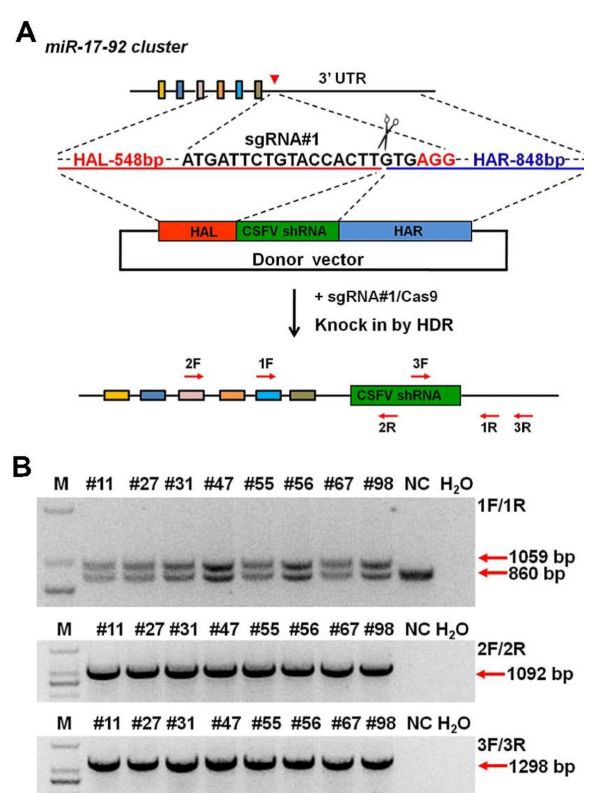
Figure 4. Selection of anti-CSFV shRNA knock-in cell clones. ( A ) Strategy of anti-CSFV shRNA knock-in into the p miR-17-92 cluster. ( B ) PCR analysis of positive PFF clones using specific primer. The 1F/1R primers were used to determine homozygosity or heterozygosity, the 2F/2R primers amplified the 5 (cid:48) junction, and the 3F/3R primers amplified the 3 (cid:48) junction. A hybrid band was formed by knock-in band (1059 bp) and wild-type band (860 bp) in the process of genomic PCR with 1F/1R; The corresponding sizes of the PCR amplicons with 2F/2R and 3F/3R are 1092 and 1298 bp. M: DNA Marker 2000. WT: negative control. H 2 O: blank control.